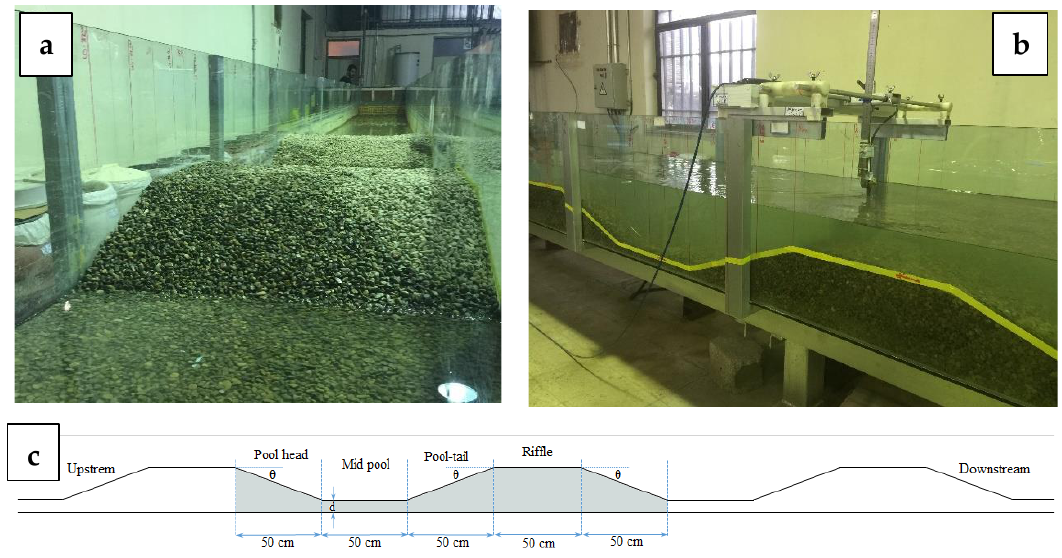
Figure 3. ( a ) Front view of the laboratory channel, ( b ) side view of the laboratory channel, and ( c ) schematic of the bed from upstream to downstream (shaded parts represent the length of the test area). Table 2. Flow conditions in the laboratory flume.